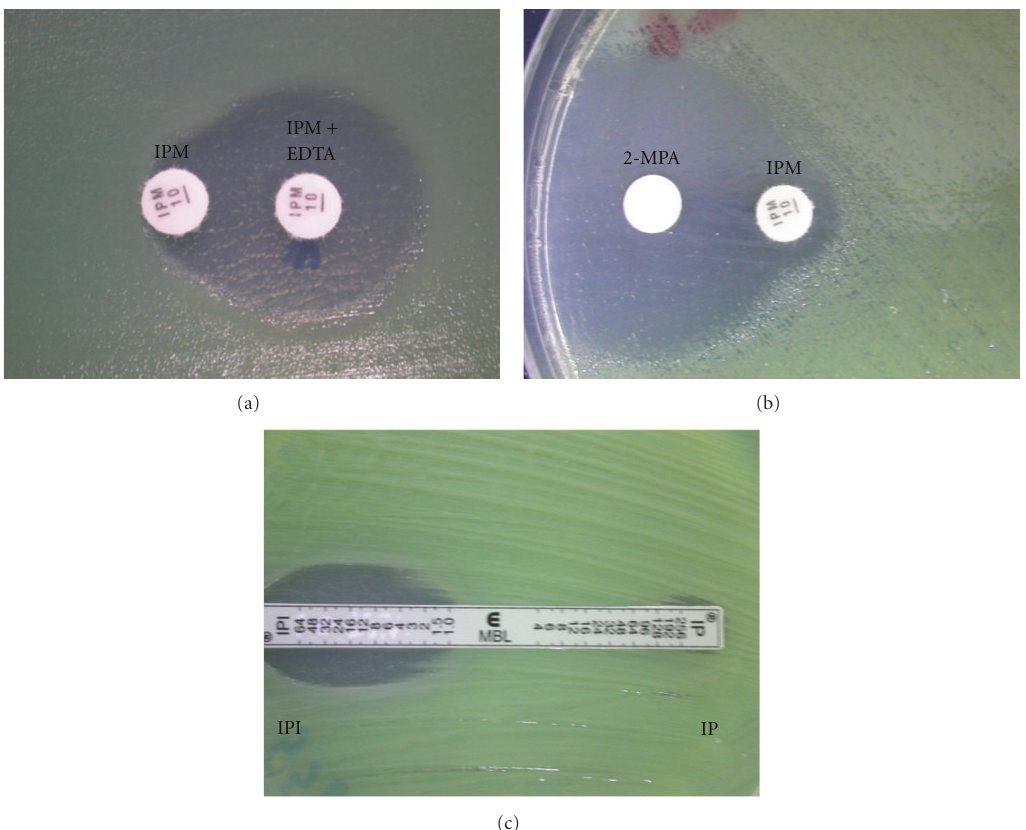
Figure 1: Phenotypic tests to detect MBL production. (a) Combined disk test (CDT) showing enhanced inhibition zone of > 7mm around IPM + EDTA disc indicating MBL positivity. (b) Double-disk synergy test (DDST) with synergistic zone of inhibition surrounding IPM and 2-mercaptopropionic acid (2-MPA) disks indicating MBL activity. (c) MBL IP/IPI E -test demonstrating enhanced MIC of imipenem in the presence of EDTA IPI with IP/IPI of ≥ 8 for MBL activity.